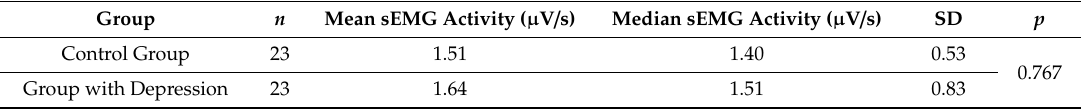
Table 4. The comparison of mean activity of masseter muscle (MM) in rest between the group without depression (control group) and the group with